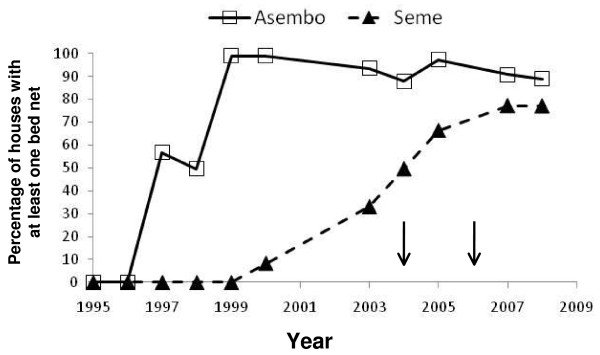
Household ownership of bed nets, defined as at least one per house, of any bed net type and whether treated or untreated, in Asembo (site of bed net trial in the late 1990s) and Seme (no bed net trial) from 1995 through 2008. Arrows indicate the initiation of subsidized national distribution of bed nets through health clinics to pregnant women and children < 5 years (2004) and a mass campaign during which 3.4 million nets were distributed for free to children < 5 years in all endemic regions of Kenya (2006).